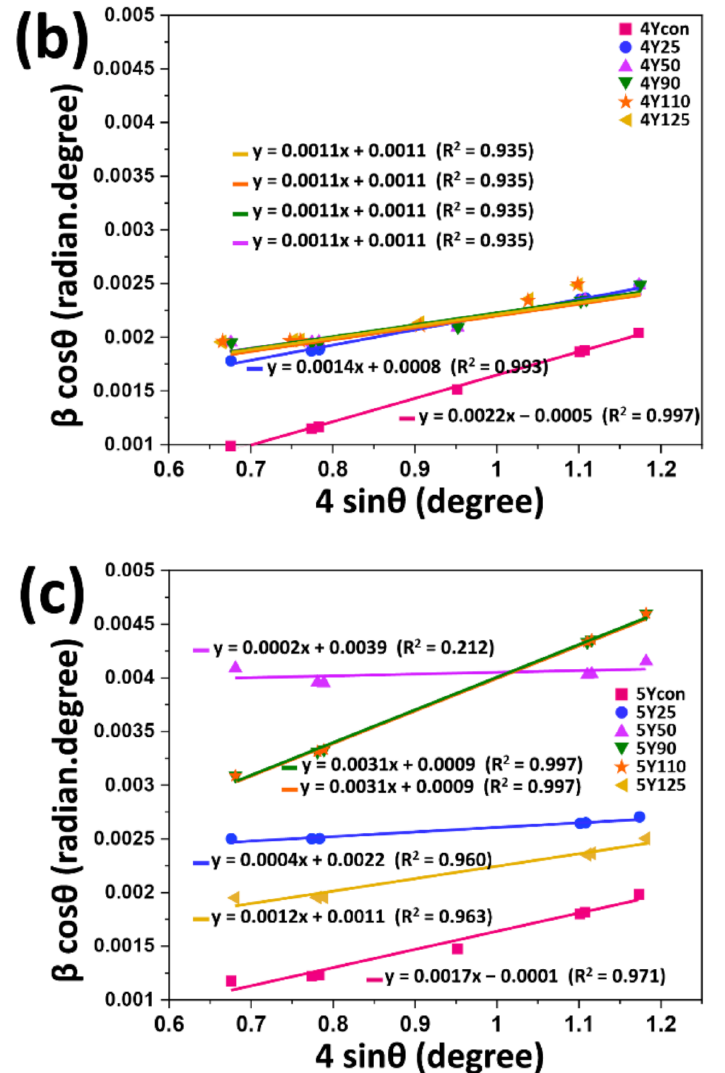
Figure 6. Williamson-Hall plots of ß cos θ against 4 sin θ calculated from XRD spectra for ( a ) 3Y subgroups, ( b ) 4Y subgroups, and ( c ) 5Y subgroups. From the linear fit to the data, 3Y110 showed the steepest negative slope while there were no lines with negative slopes for 4Y or 5Y